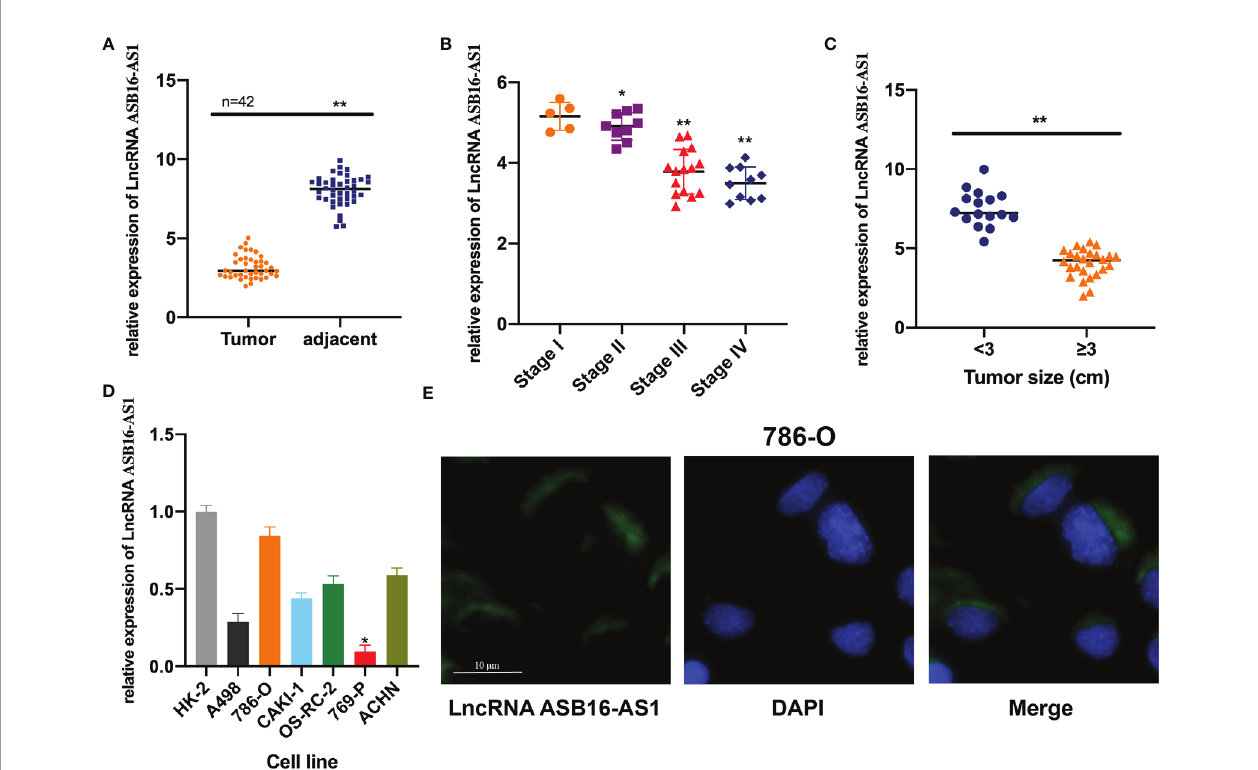
FIGURE 1 | The expression of ASB16-AS1 in renal cell carcinoma (RCC) tissues. (A) qRT-PCR analysis showing decreased ASB16-AS1 expression in 42 RCC tumor tissues compared with paired adjacent non-diseased tissues. (B) ASB16-AS1 expression is signi fi cantly decreased in RCC tumors of higher stages (N=5 – 15). (C) ASB16-AS1expression is signi fi cantly decreased in larger tumors (N=16 smaller tumors and 26 larger tumors). (D) The expression of ASB16-AS1 varies across different RCC cell lines and the human kidney proximal tubular epithelial cell line, HK-2. (E) Fluorescent in situ hybridization showing the cytoplasmic location of ASB16-AS1 in 786-O cells. Scale bar – 10 m m. All experiments were repeated at least three times. *P < 0.05, **P <